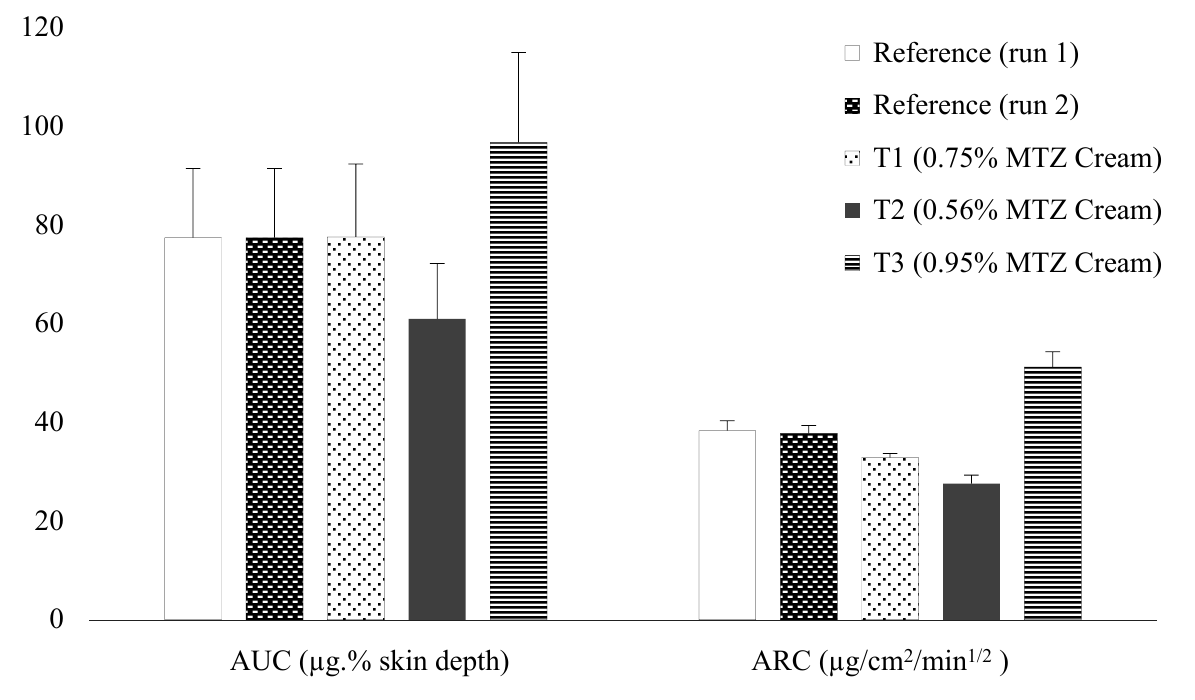
Figure 1. Comparison of AUC and ARC deduced from the TS study (in vivo) in human participants (n = 10) and IVRT studies (in vitro) (n = 6).